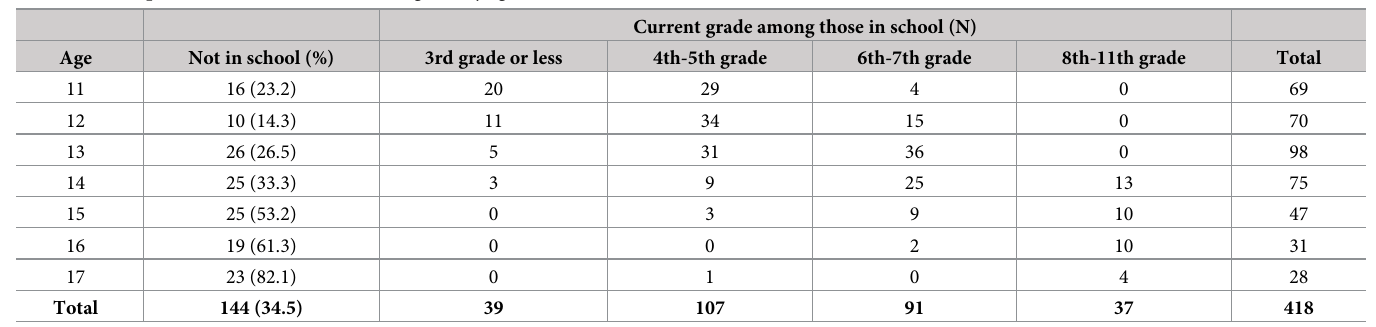
Table 2. Participants’ current school status and grade by